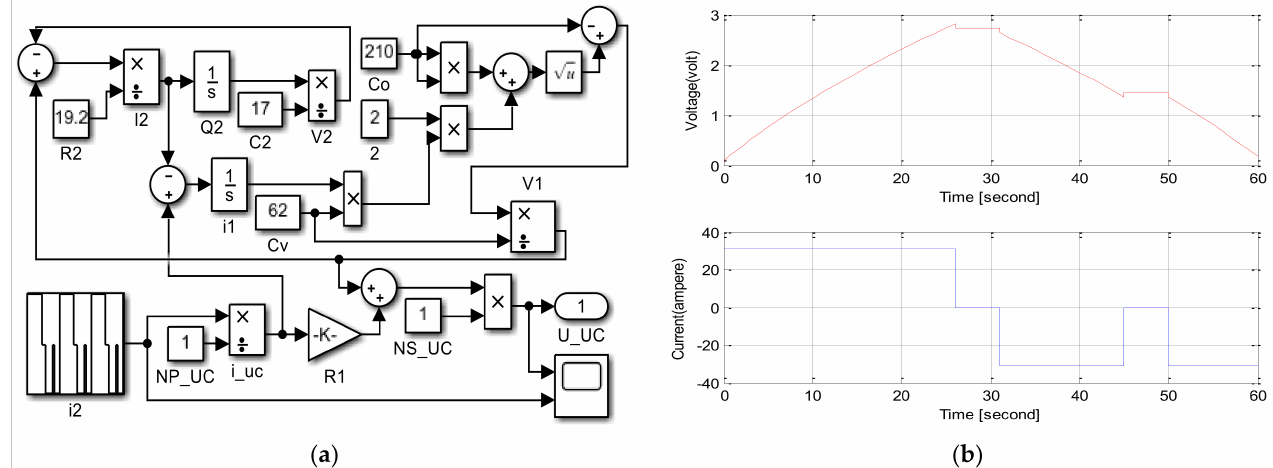
Figure 15. ( a ) SC module model in MATLAB/Simulink. ( b ) CAP/ESR waveforms of SC [169].